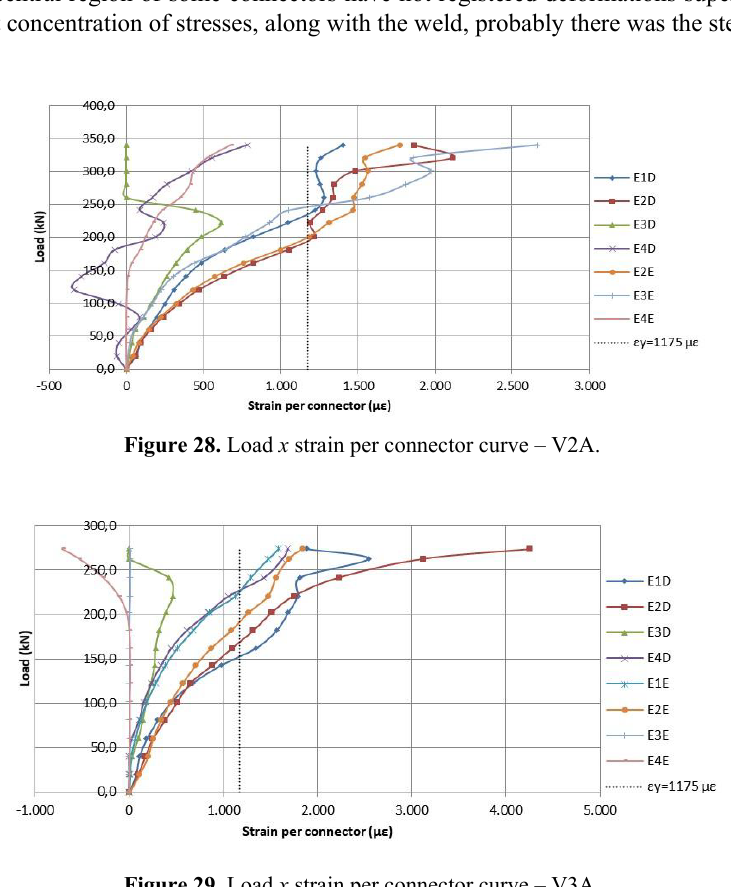
Figure 29. Load x strain per connector curve –